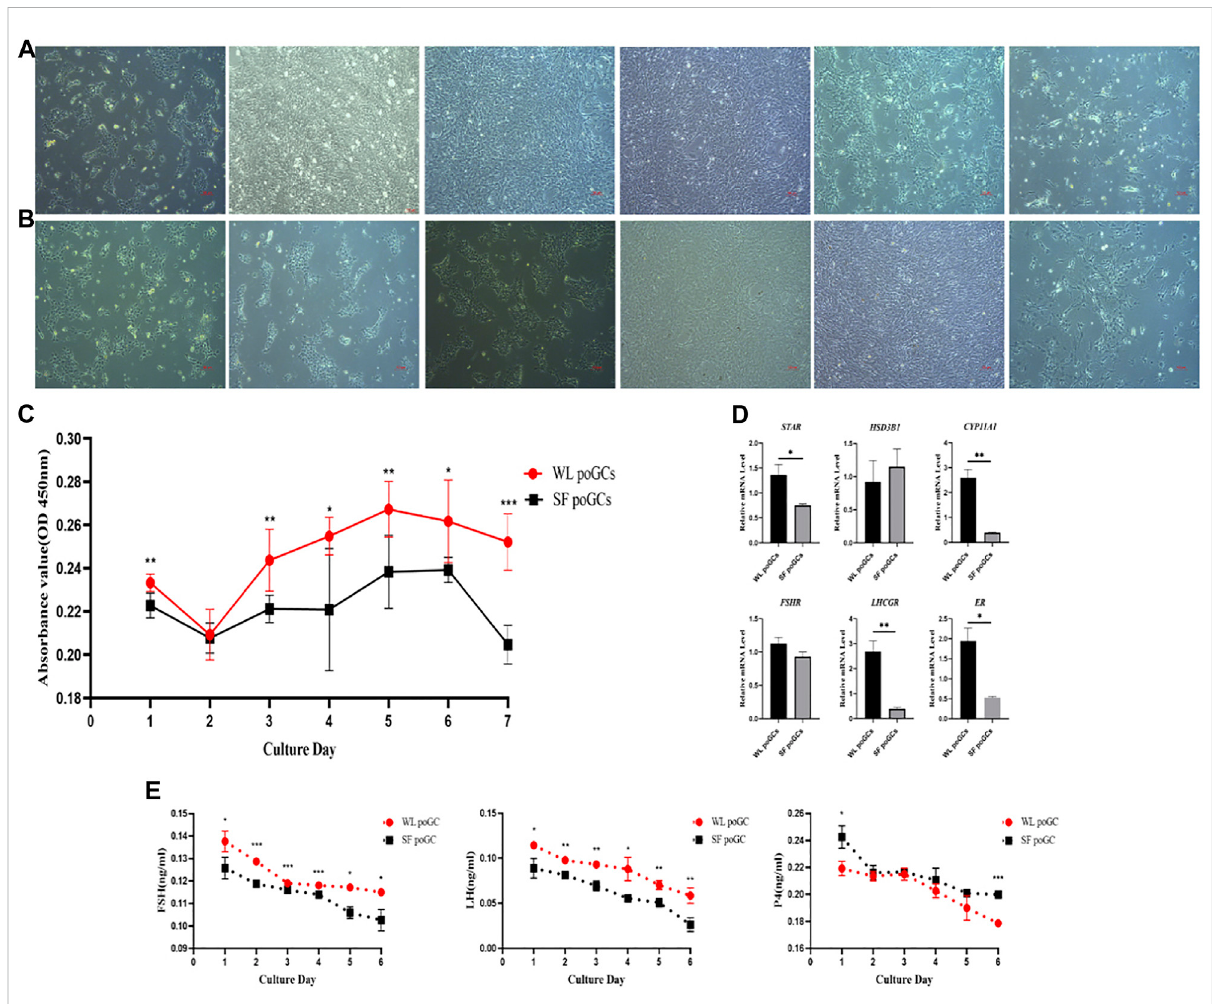
FIGURE 5 Comparison of proliferation and differentiation between WL and SF poGCs cultured in vitro . (A) Morphology of WL poGCs cultured in vitro (1 – 6 days). (B) Morphology of SF poGCs cultured in vitro (1 – 6 days). (C) Comparison of WL poGCs and SF poGCs cell proliferation ability. (D) Expression of genes associated with the synthesis of sex hormones and receptors in GCs were detected. (E) Comparison of secretion FSH, LH and P4 between WL poGCs and SF poGCs. (* p < 0.05; ** p < 0.01; *** p <